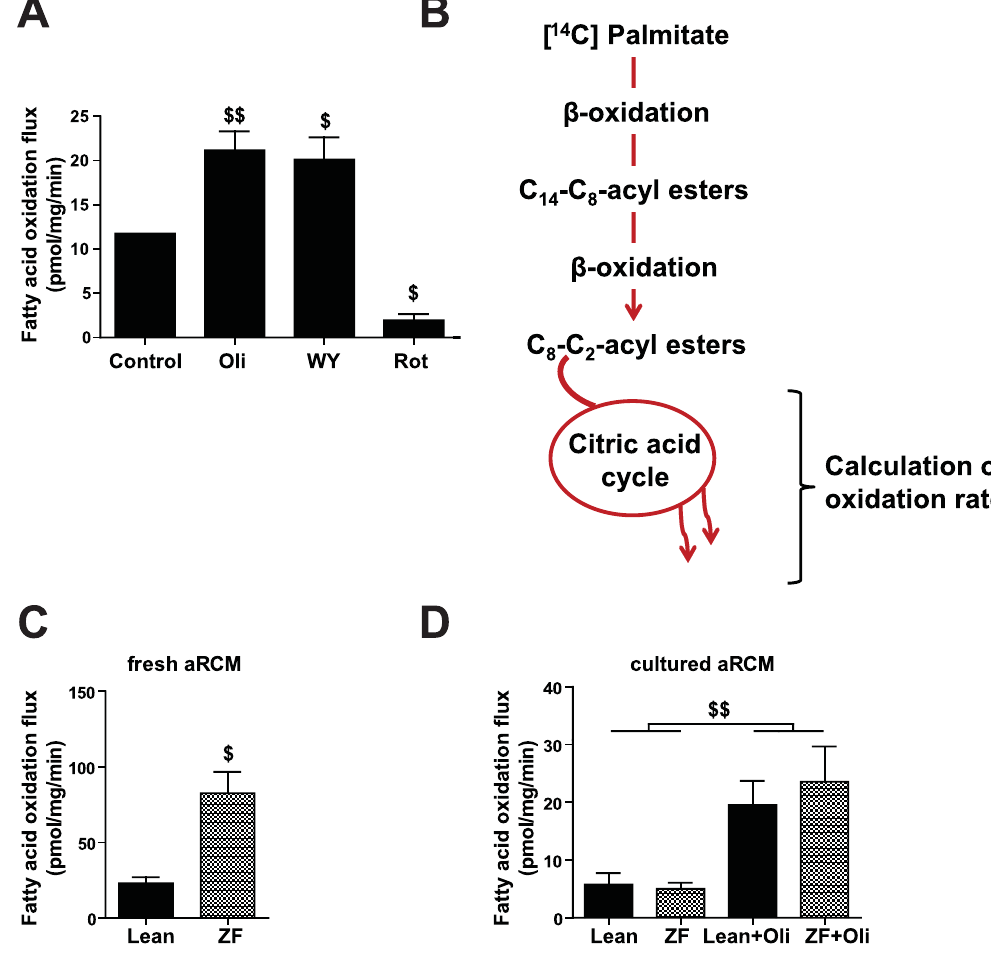
Figure 2. Modulation of FAO flux in aRCM. All aRCM were cultured in laminin-coated plates for 48 h; ( A ) FAO flux in untreated (control) adult rat cardiomyocytes (aRCM), or stimulated for 30 min with 5 μ M oligomycin (Oli), or 3 μ M rotenone (Rot), or 48 h with 10 μ M of WY-14,643 (WY). Results are presented as mean ± SEM; $ p < 0.05; $$ p < 0.01; $$$ p < 0.001 vs control (n = 17, 6, 2, 3). ( B ) Different stages of 14 C-palmitate oxidation (adapted from 17 ); ( C ) FAO flux in untreated fresh aRCM isolated from lean or zucker fatty (ZF) rats, n = 3 per group, $ p < 0.05 vs lean; ( D ) FAO flux in 48 hours cultured aRCM from lean or ZF rats untreated or stimulated for 30 min with 5 μ M oligomycin (Oli), n = 3 per group, $$ p < 0.01 oligomycin vs untreated. FAO fluxes are calculated from the amount of radiolabeled palmitate that is converted into 14 CO 2